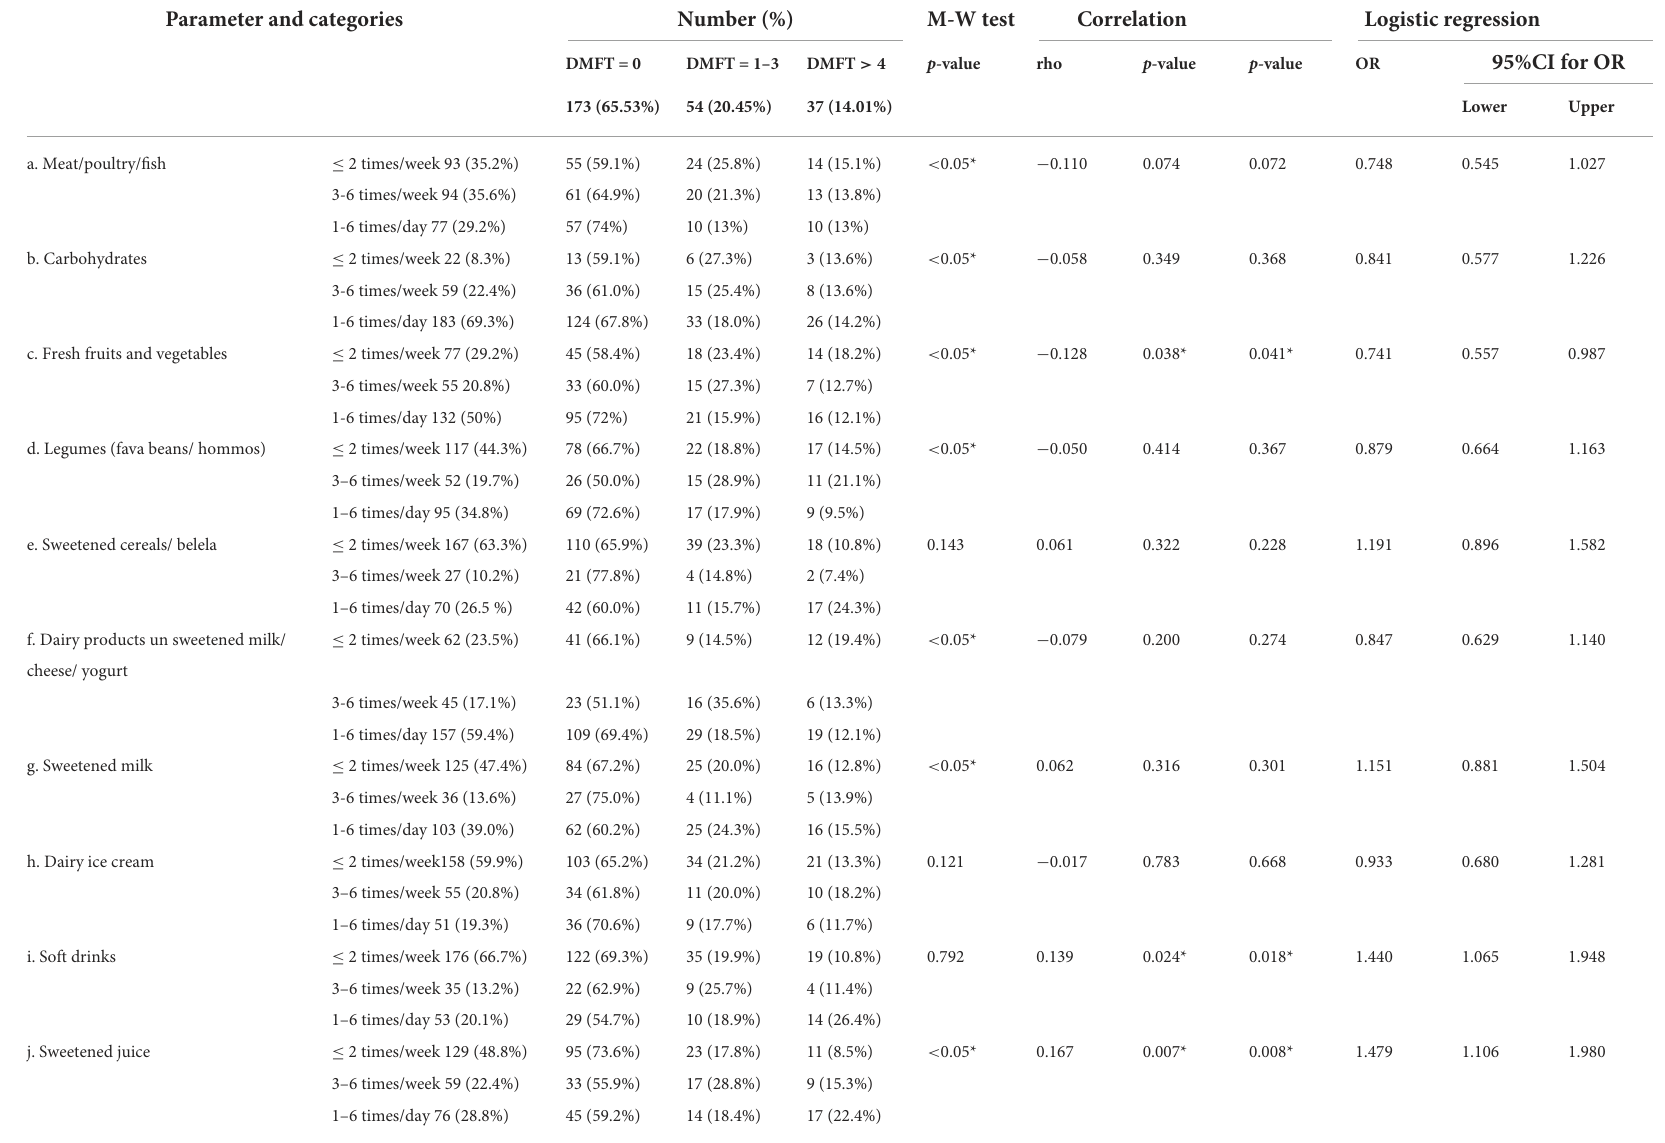
TABLE 9 Correlation between DMFT index and frequency of intake of different food items (Total number